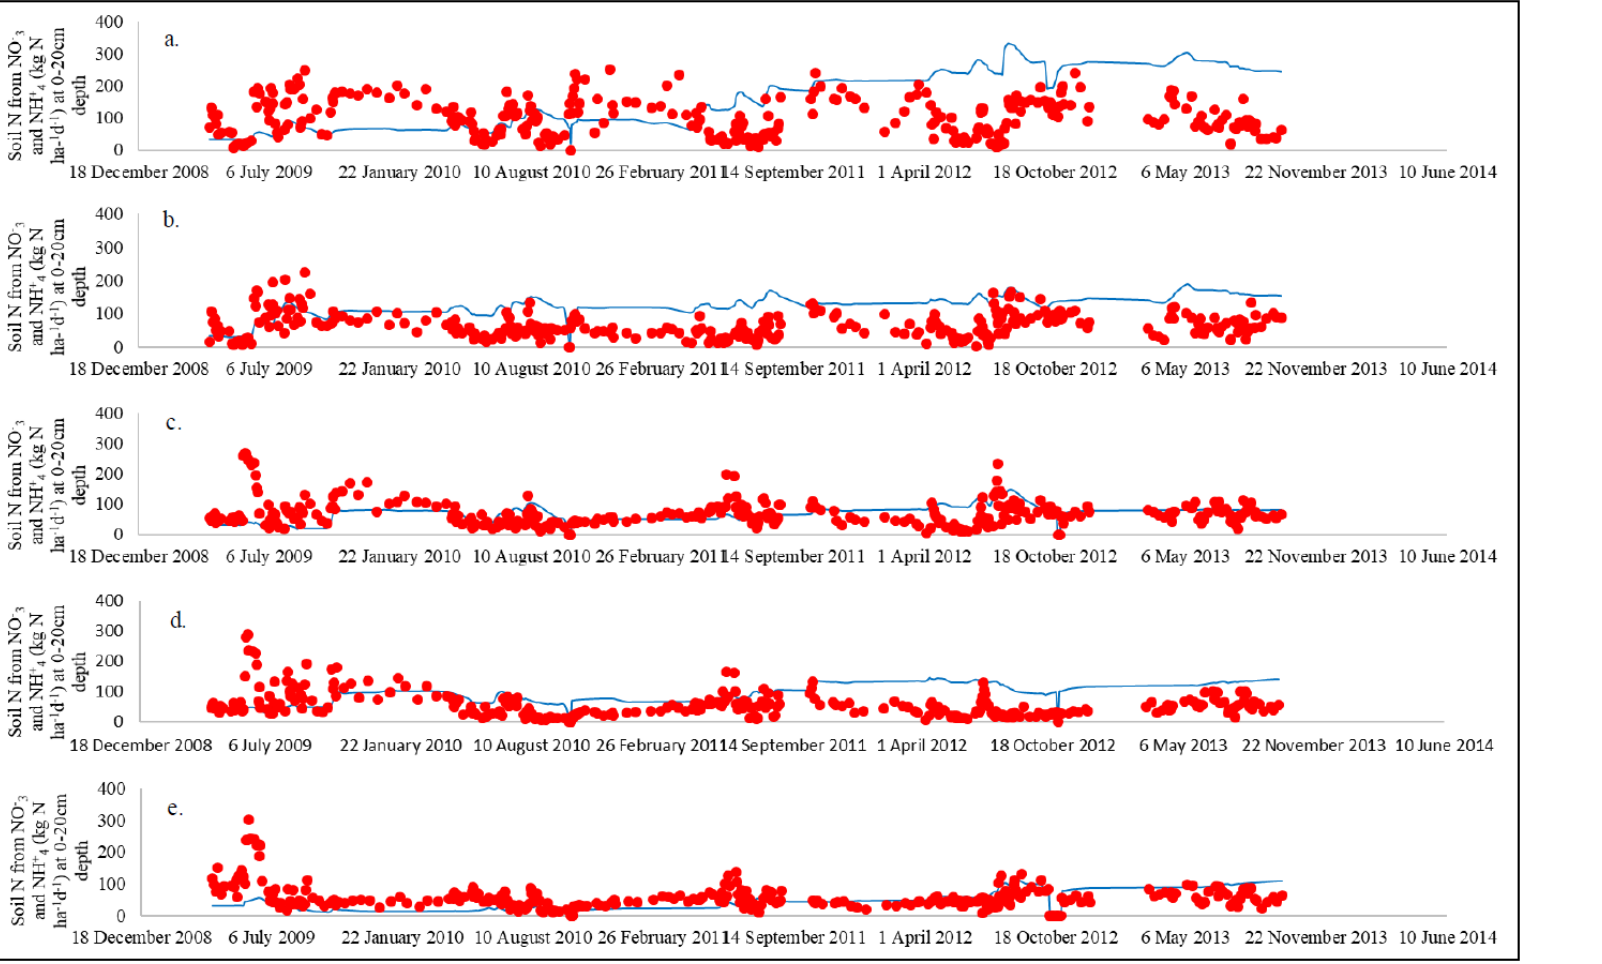
Figure 3. Field observed ( ● ) and DNDC simulated (line) daily soil N (kg N ha -1 d -1 ) for the conventional winter wheat-summer maize double-cropping system (Chem. W/M; a.), optimized winter wheat-summer maize double-cropping system (Opt. W/M; b.), winter wheat-summer maize-fallow-spring maize system (W/M-M; c.), winter wheat-summer soybean-fallow-spring maize system (W/S-M; d.), and spring maize system (M; e.) over the experimental period from June 2009 to June 2013.